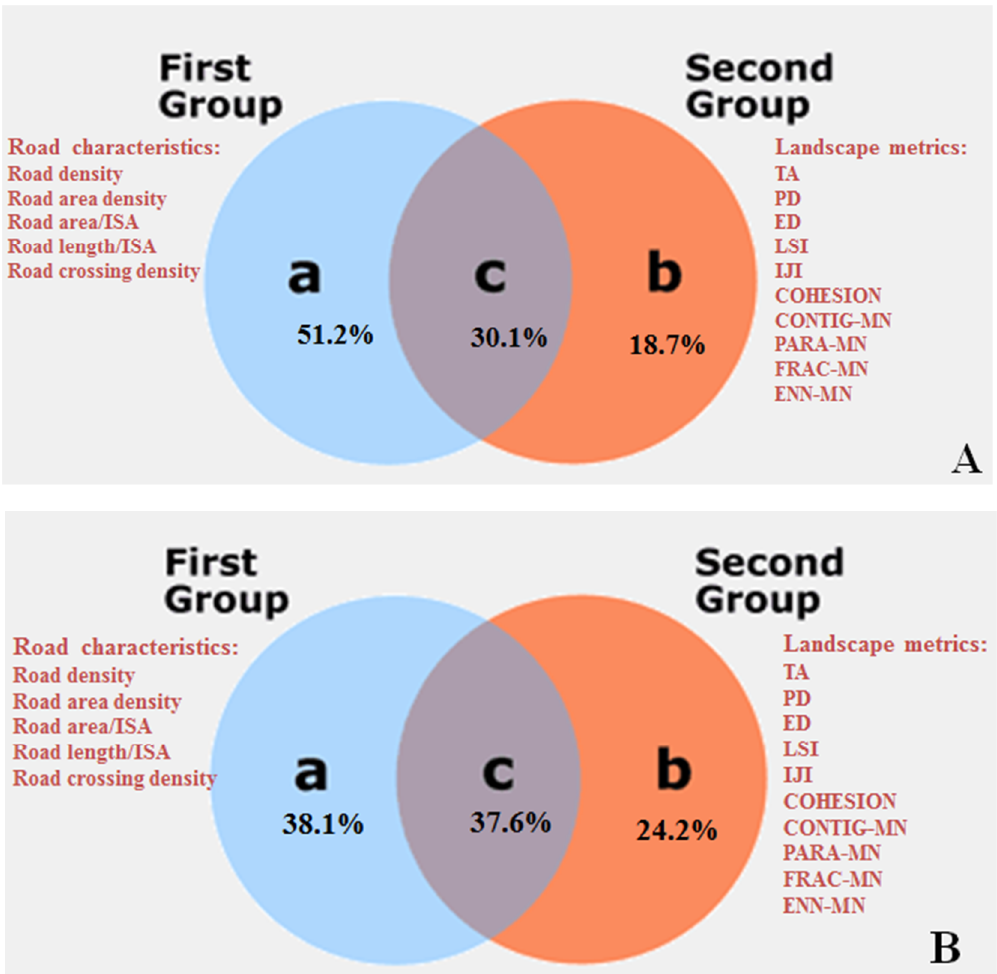
Figure 7. Partitioning of the RDA ordination-based forest attribute variation for the entire urban region. ( A ) Variation partitioning for structural attributes and ( B ) variation partitioning for taxonomic attributes.